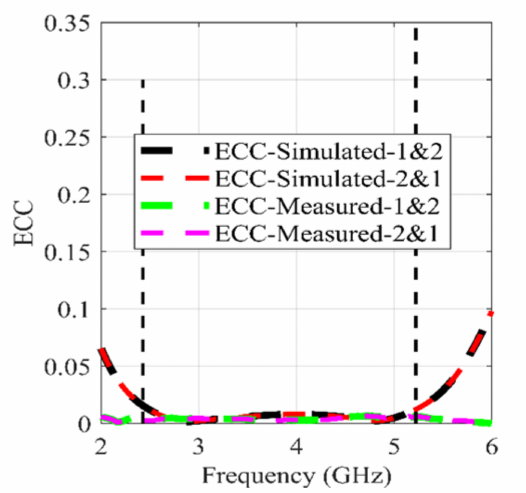
Figure 16. The measured and simulated ECC for mid-band MIMO configuration.